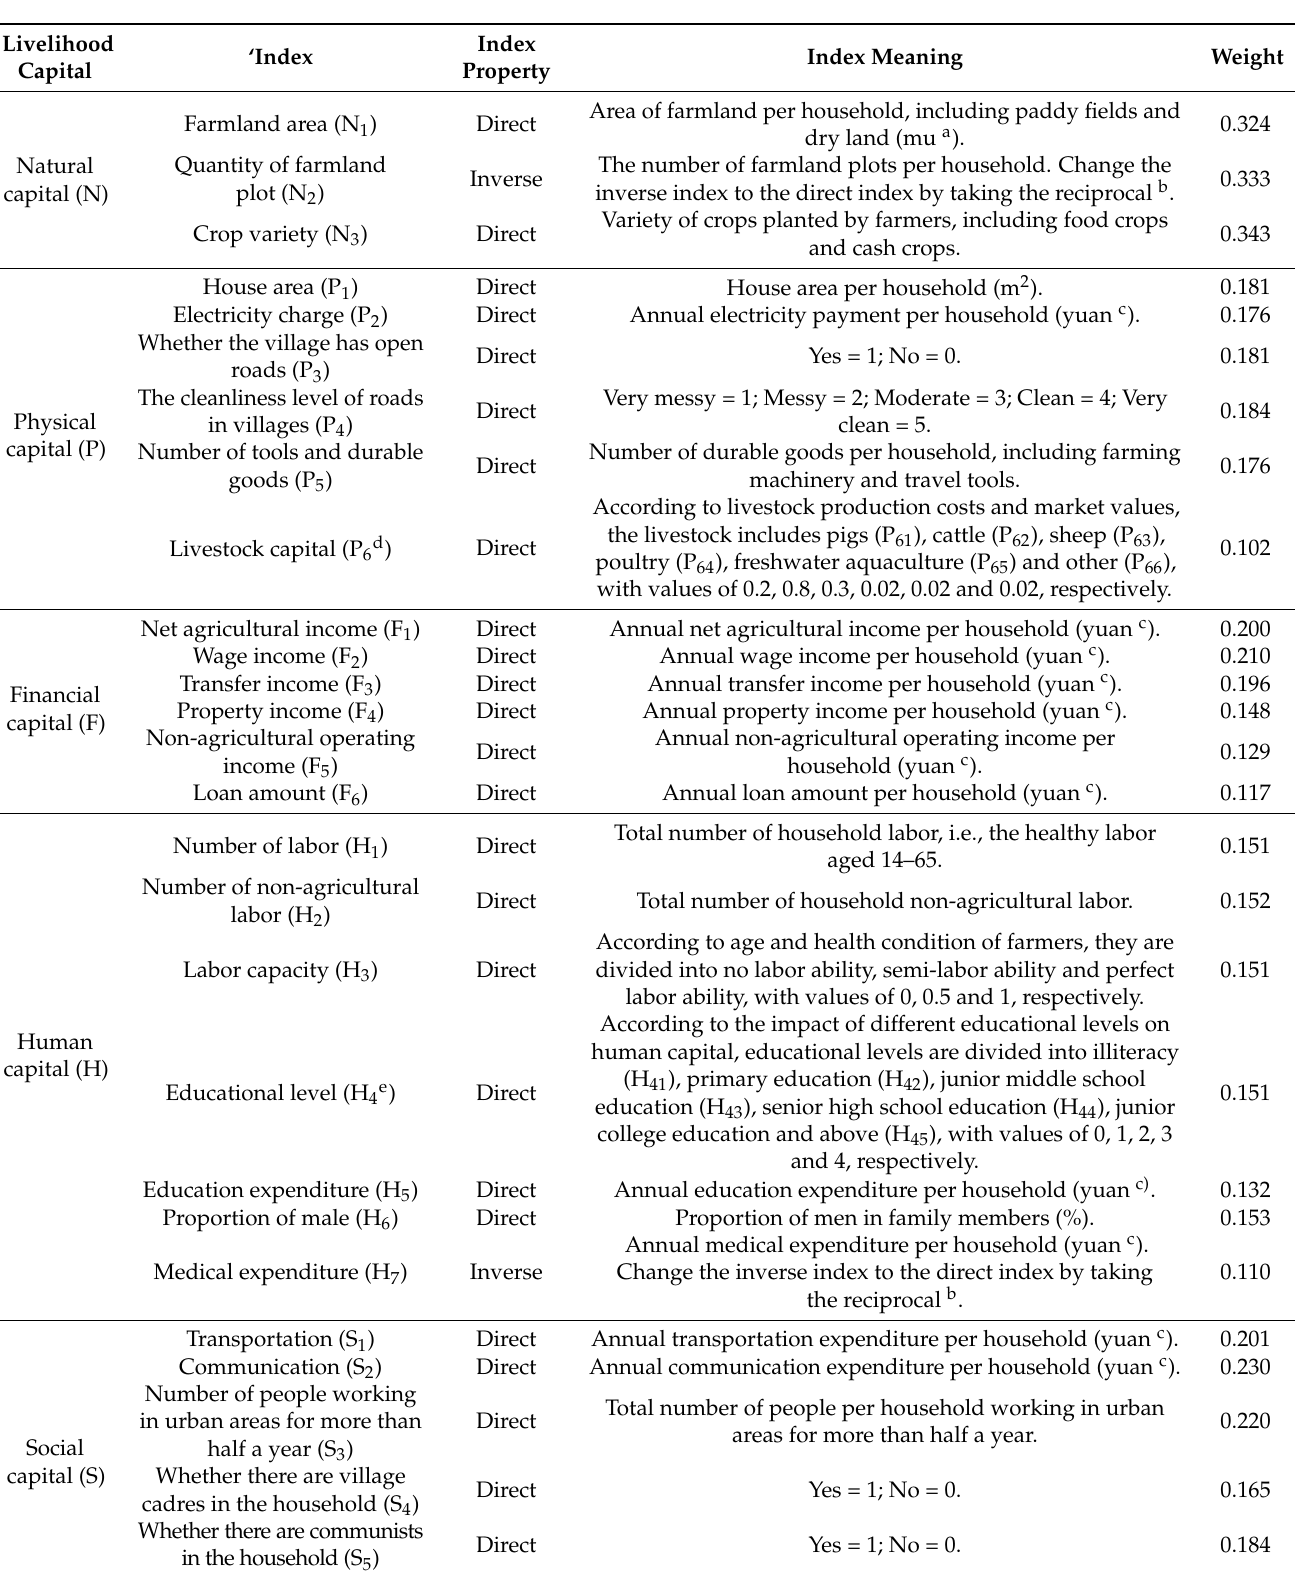
Table 2. Measurement index system of farmers’ livelihood